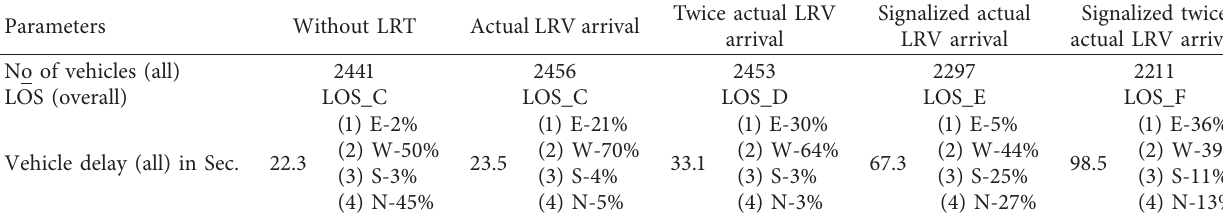
Table 3: Sebategna level crossing simulation